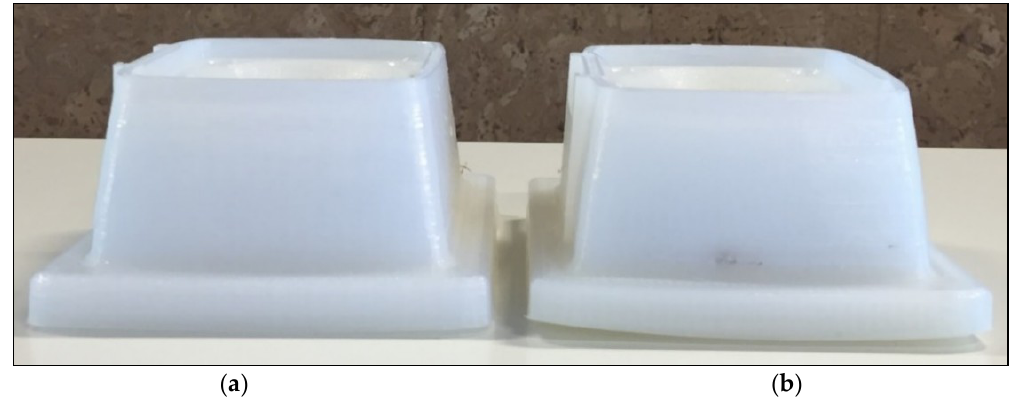
Figure 6. Case study printed parts: ( a ) Support manufactured with an infill percentage of 25%; ( b ) support manufactured with an infill percentage of 75%.